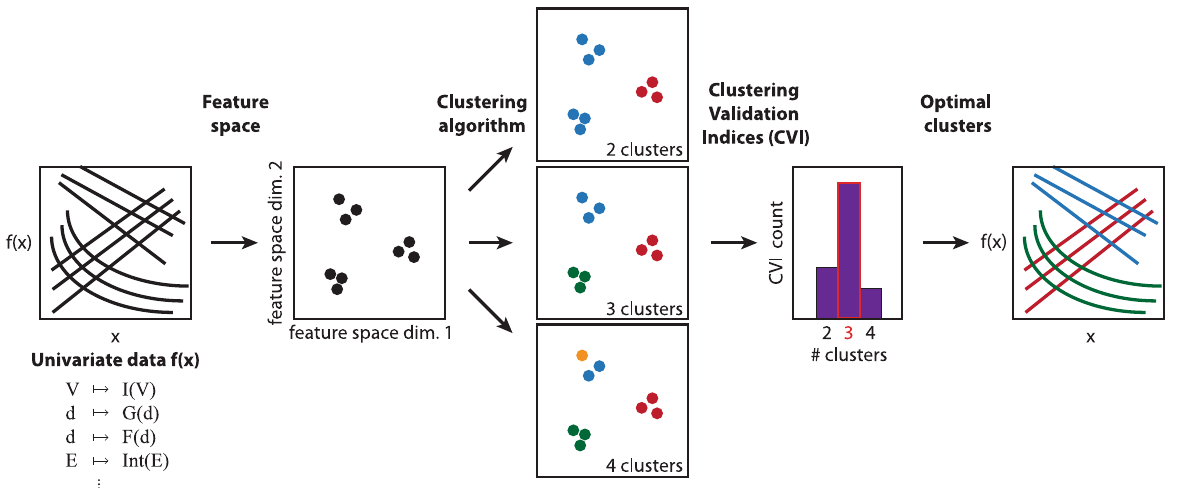
Fig. 1 Concept of our approach for univariate data classi fi cation. Any dataset in which the data depends on a single variable (for instance current I vs. bias voltage V , conductance G vs. electrode displacement d , force F vs. displacement d , intensity Int vs. energy E , etc.) can be converted into a feature vector. The feature space spanning the entire dataset is then split into clusters (represented using different colors) using a clustering algorithm. Finally, cluster validation indices (CVIs) are used to estimate the optimal number of clusters